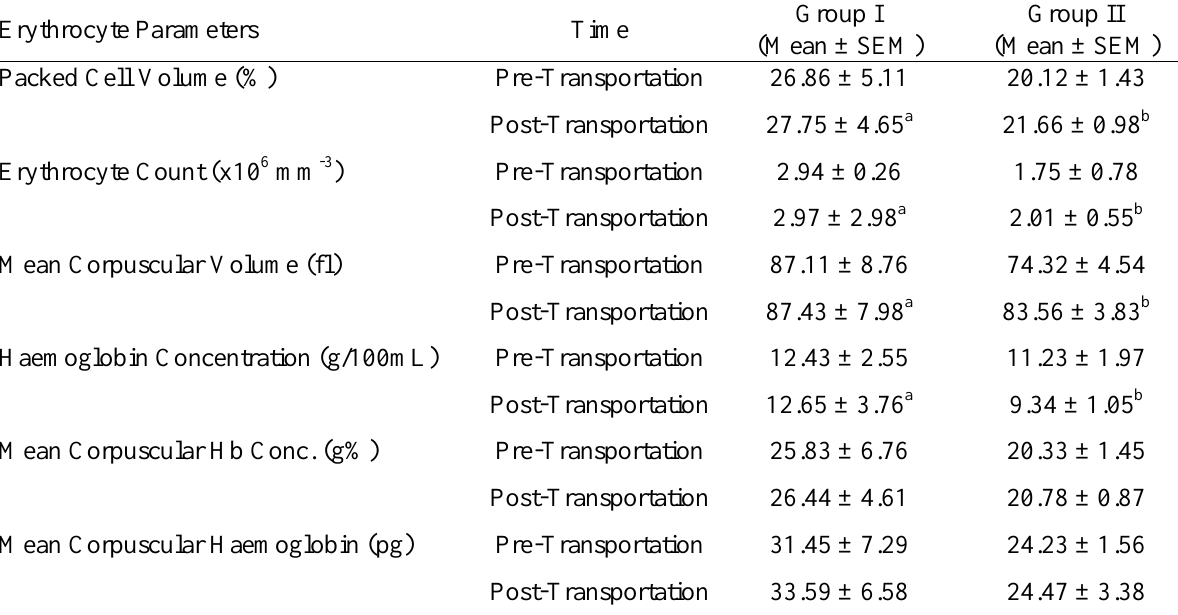
Table 2: Erythrocyte Parameters of Clarias gariepinus subjected to Road Transportation Erythrocyte